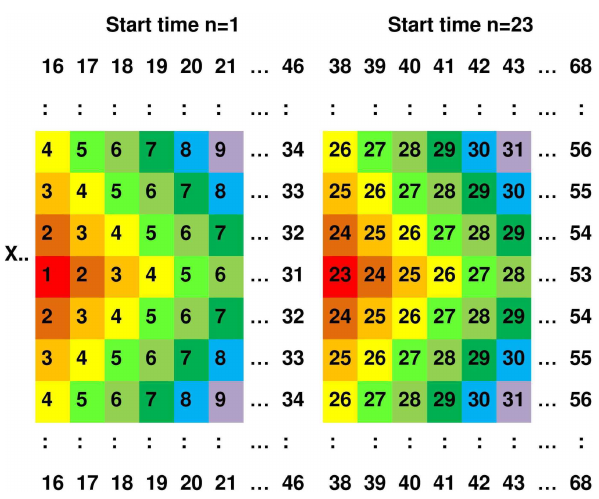
Figure 2. Scheme for estimates of simulated precipitation fields from precipitation time series gained on the main building of the GEOMAR in Kiel (54.3 ◦ N, 10.2 ◦ E) at a time interval of 8min. The numbers, additionally highlighted by colours, indicate the n th 8min interval of the time series. Assuming a speed of motion of precipitat- ing clouds of 5ms − 1 , each 8min interval is equivalent to a displace- ment of 2.4km. Thus, a spatial field of 75km × 75km is simulated by 31 elements × 31 elements of the 8min time series. Since ERA- Interim precipitation is accumulated over 3h, simulated data have to be averaged over 23 consecutive fields (23 × 8min = 184min). Left: scheme for a spatial field representing ERA-Interim resolu- tion at the beginning of a 184min period, right at the end of this period. Start elements are indicated by red. The X indicates an ob- servation, which is taken randomly from elements n = 1 to n = 68 of the time series for ERA-Interim simulations and from elements n =− 5 to n = 37 for HOAPS simulations due to collocation criteria (Sects. 3.1 and 3.2).